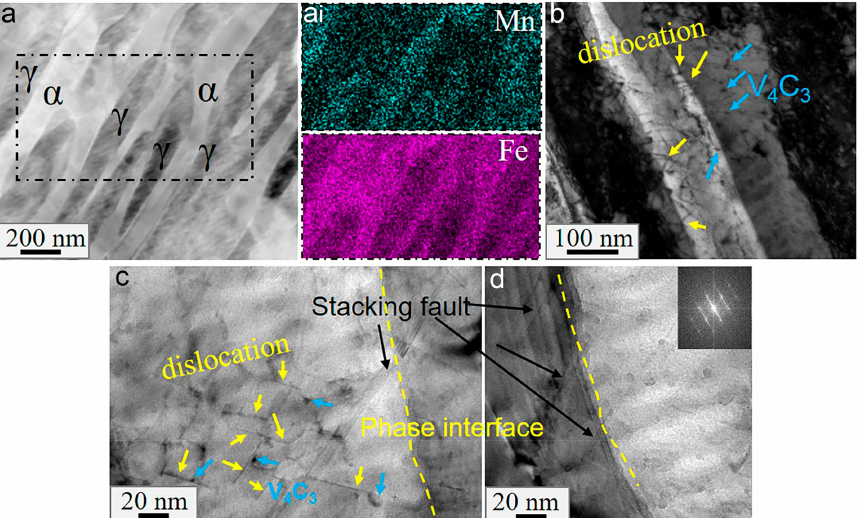
Figure 9. TEM micrographs of sample LV700: ( a ) the dark field images, where ( a i ) is the EDXS surface analysis of ( a ); ( b ) the distribution of dislocations; ( c ) microstructure near the phase interface; ( d ) the distribution of stacking faults, where the inset is the corresponding fast Fourier